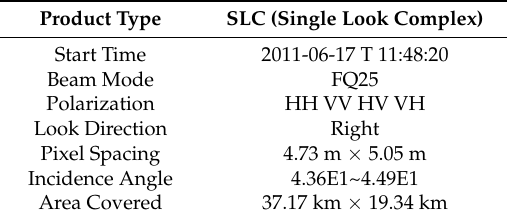
Table 3. Information on the image of RadarSAT-2 used in this study (Dataset